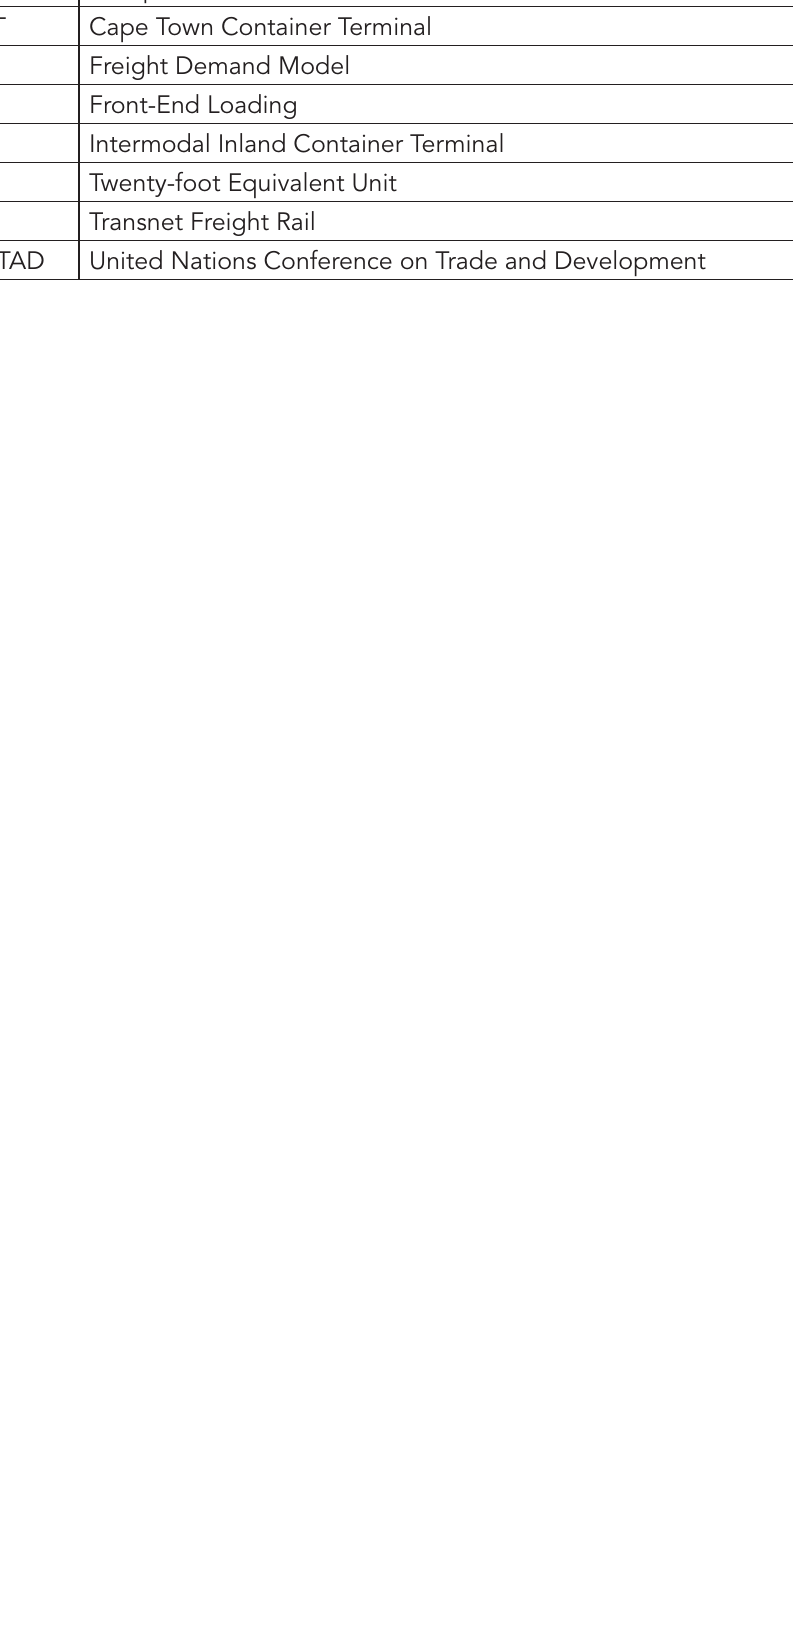
CAGR Compounded Annual Growth